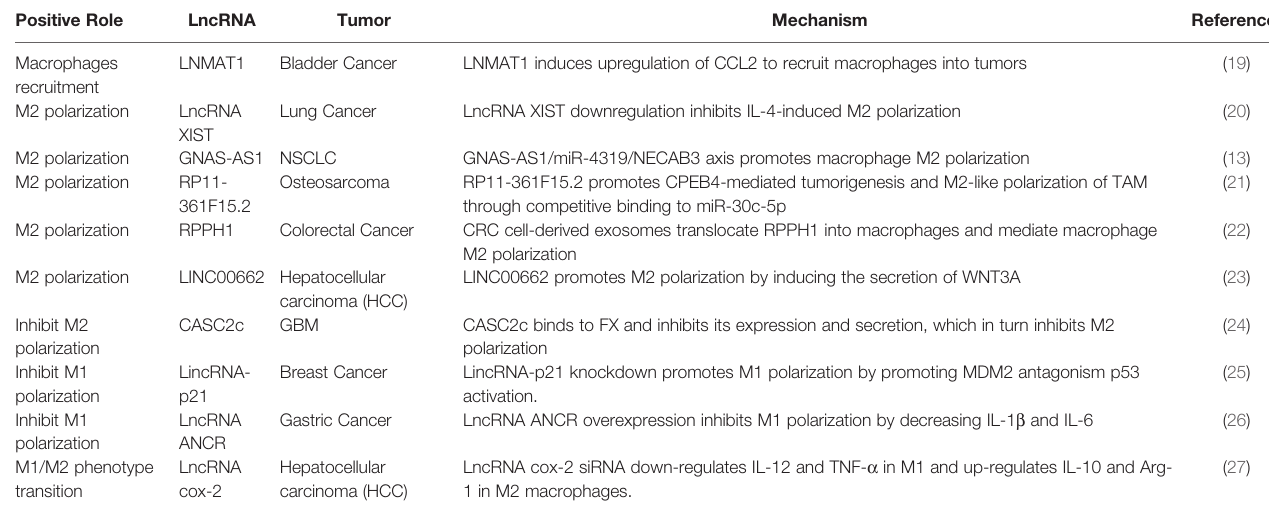
TABLE 1 | LncRNA affects macrophage recruitment, polarization, phenotypic transition. Positive